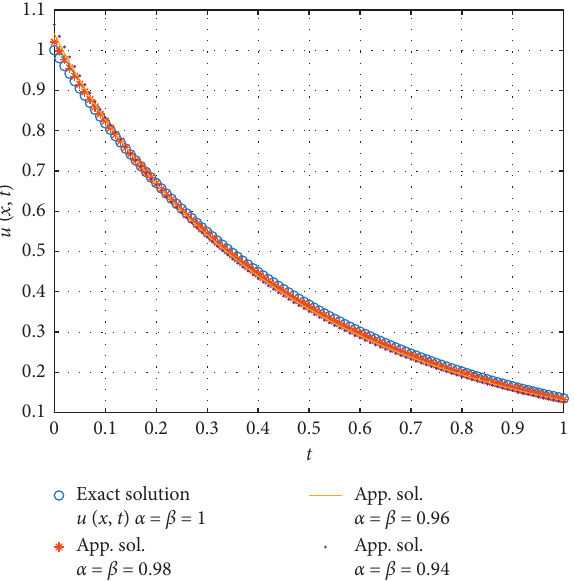
Figure 5: The exact and approximate solutions of u ( x,t ) for Example 5, when α � β .